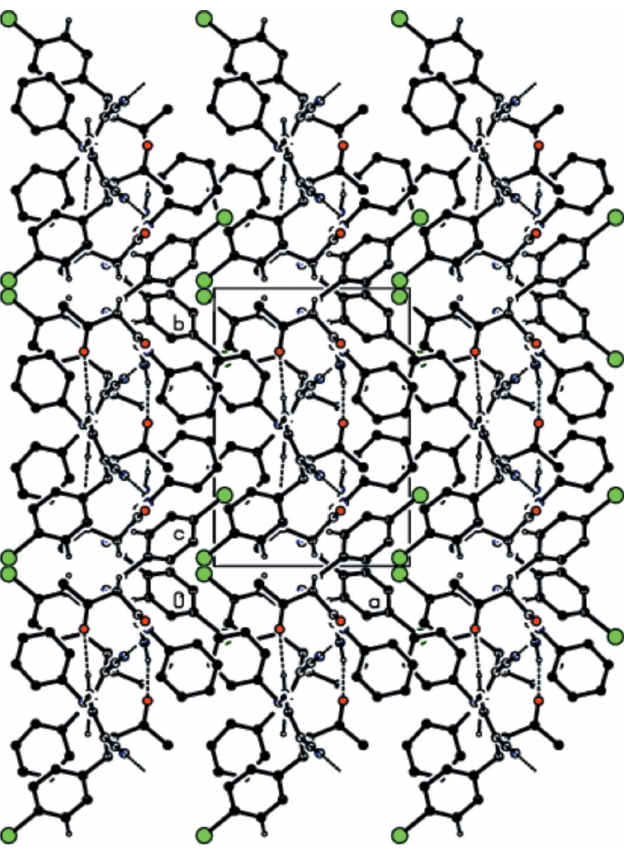
Figure 6 The C—Br (cid:2)(cid:2)(cid:2) (cid:2) and C O (cid:2)(cid:2)(cid:2) (cid:2) interactions in the structure of the title compound viewed down the a